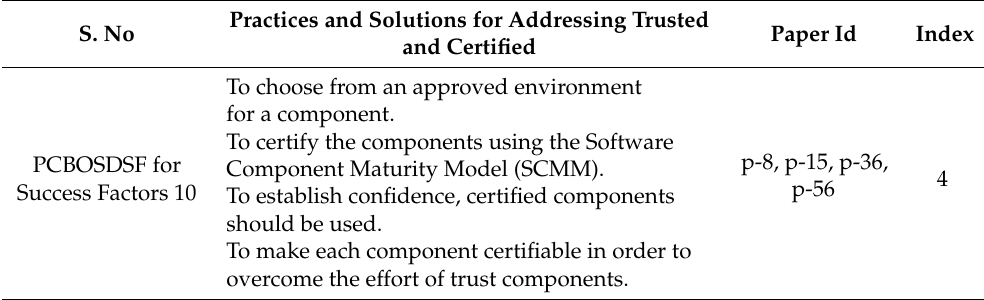
Table 14. CBOSDSF 10: Trusted and